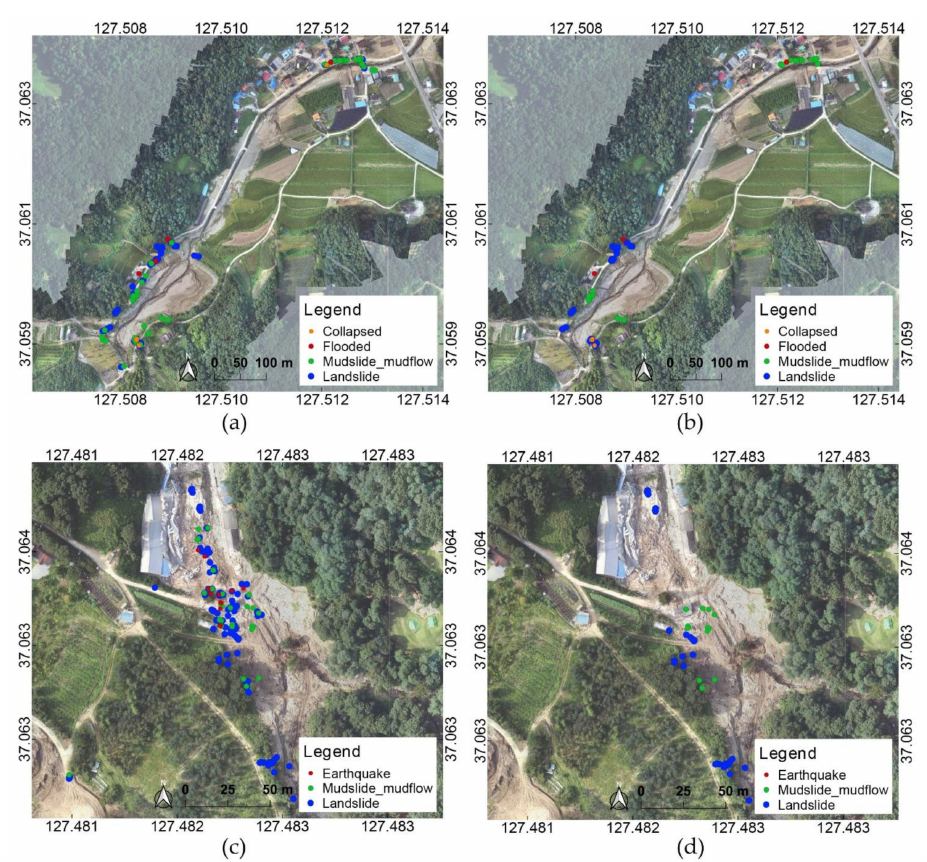
Figure 9. Distribution of results based on analysis of 5 August dataset: ( a ) results without hotspot analysis in Yul, ( b ) results with hotspot analysis in Yul, ( c ) results without hotspot analysis in Iljuk, and ( d ) results with hotspot analysis in Iljuk. The coordinates refer to WGS84 (EPSG: